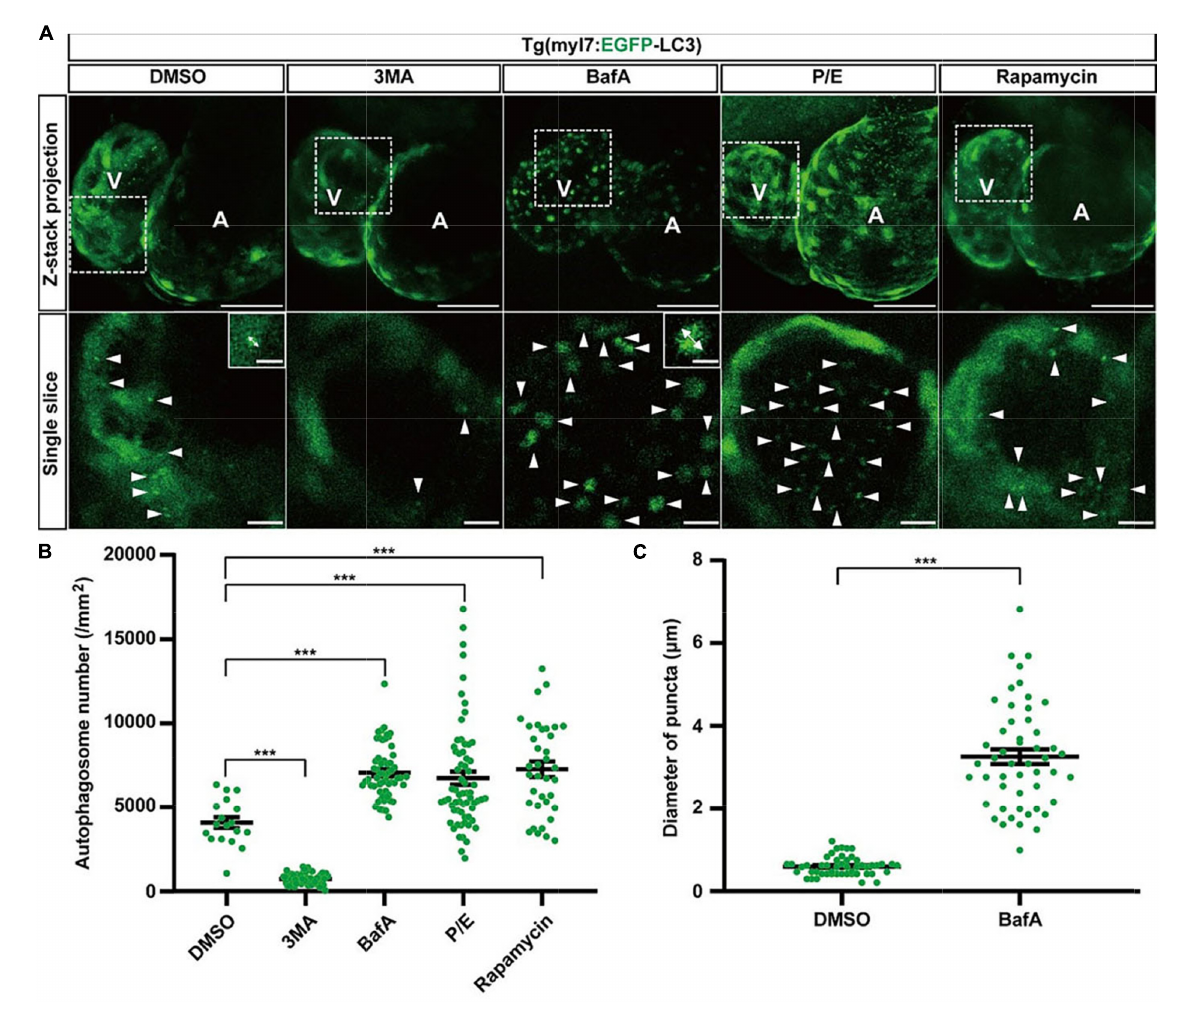
FIGURE2 The density of autophagosomes in zebrafish heart is regulated by known autophagy-modulating drugs. (A) Representative images of 3-dpf zebrafish heart of Tg(myl7:EGFP-LC3) line when treating with indicated drugs for 24 h. The top row shows the Z-stack maximum projections (scale bar: 50 µ m), the bottom row shows the single slice (scale bar: 10 µ m), inset in the bottom row shows the single punctum in indicated treated groups (scale bar: 3 µ m). Arrowhead represents the autophagosome, double arrow line represents the diameter of the autophagosome. (B) Quantification of the density of autophagosomes in 3-dpf zebrafish heart of Tg(myl7:EGFP-LC3) line when treating with indicated drugs for 24 h. The data are shown as mean ± s.e.m for each group. n = 18 in control group, n = 55 in 3MA group, n = 58 in BafA group, n = 65 in P/E group, and n = 36 in Rapamycin group. (C) Quantification of the diameter of puncta in 3-dpf zebrafish heart when treated with BafA compared with the control group. n = 50 in the control group, and n = 50 in the BafA group. *** p < 0.001. A, atrium; V, ventricle.